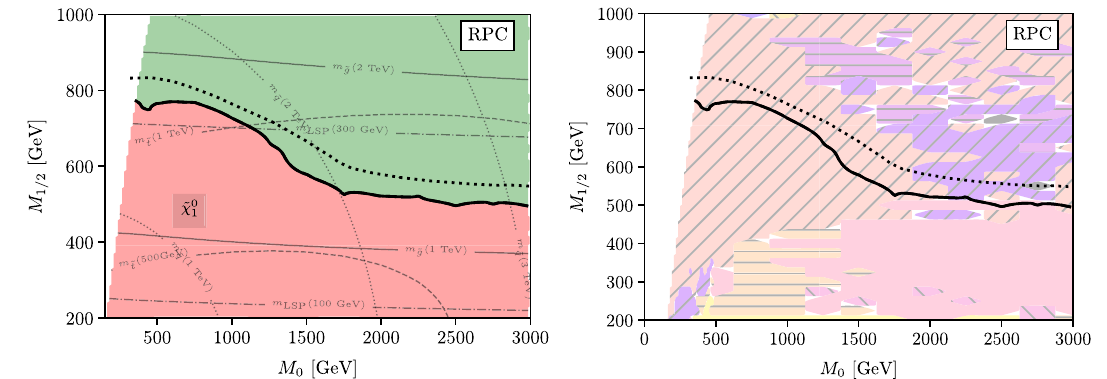
Fig. 11 LHC exclusion limits in the M 0 – M 1 / 2 plane determined by CheckMATE (black solid line) using the RPC–CMSSM with the remainingmodelparameterssettotan β = 30, μ > 0and A 0 = − 2 M 0 . On the left-hand side, the red region below the solid line is excluded, the green region is allowed by CheckMATE . The black dotted line denotes the corresponding ATLAS bound from Ref. [172]. The discrep- ancyisdiscussedinthetext.Theleft-handfigurefurthercontainsinlight